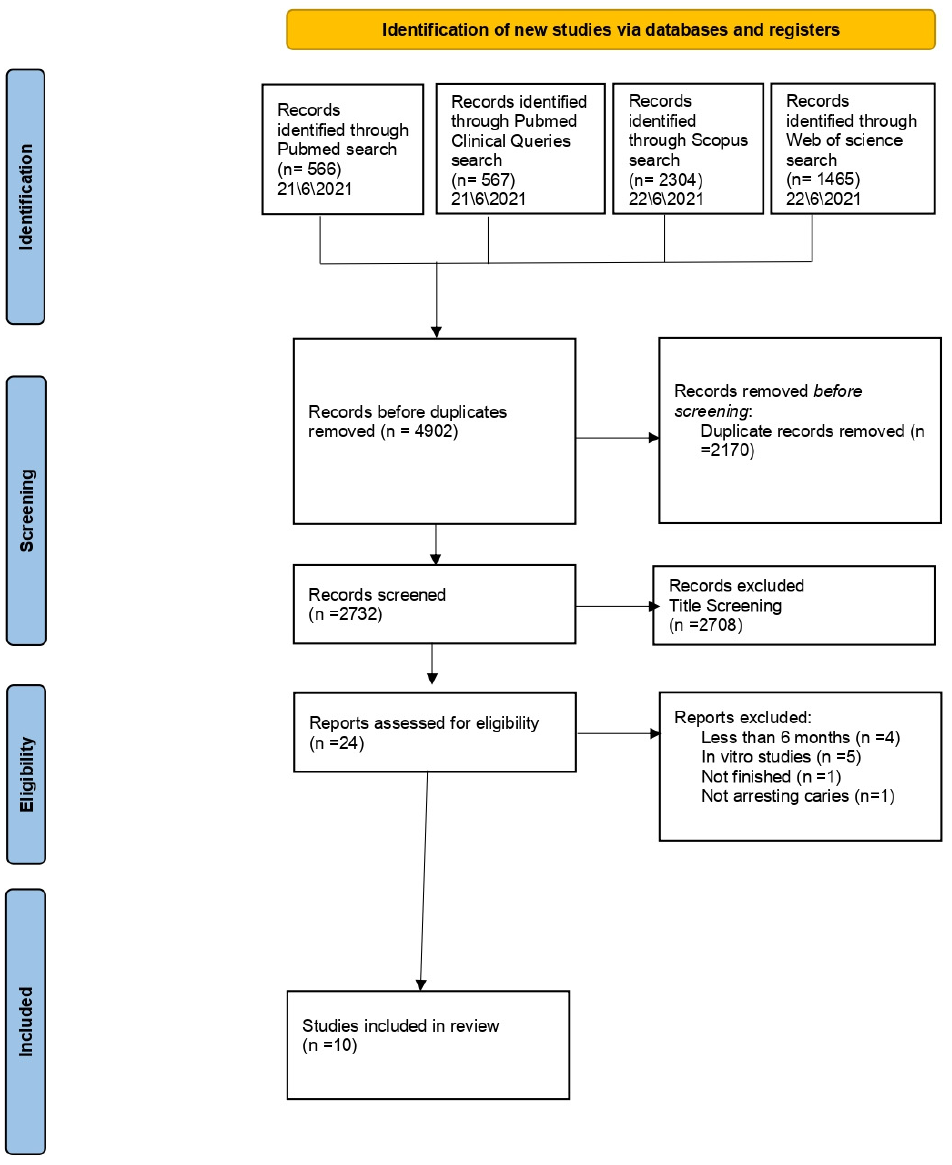
Figure 1. Flow diagram of the study selection